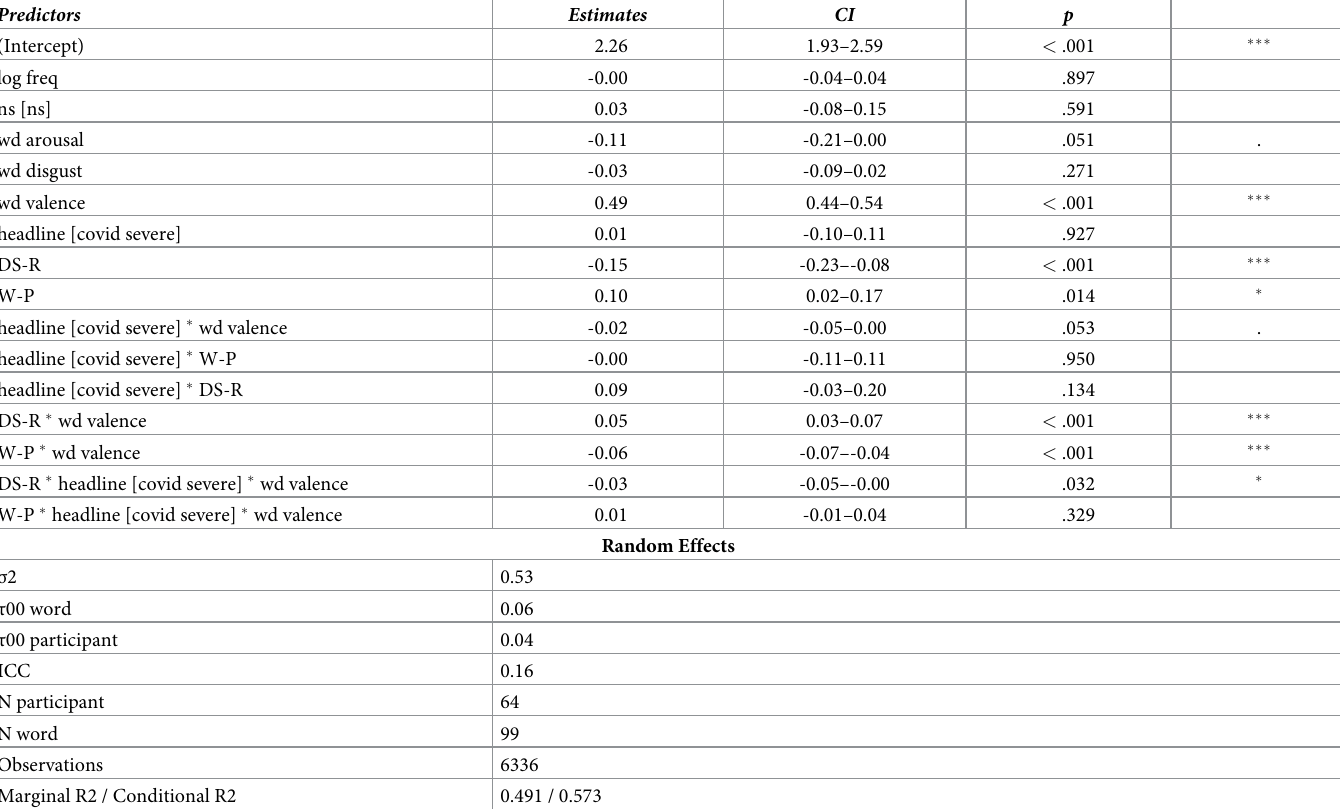
Table 4. Summary of the linear mixed-effects model with valence rating as a dependent variable. Predictors